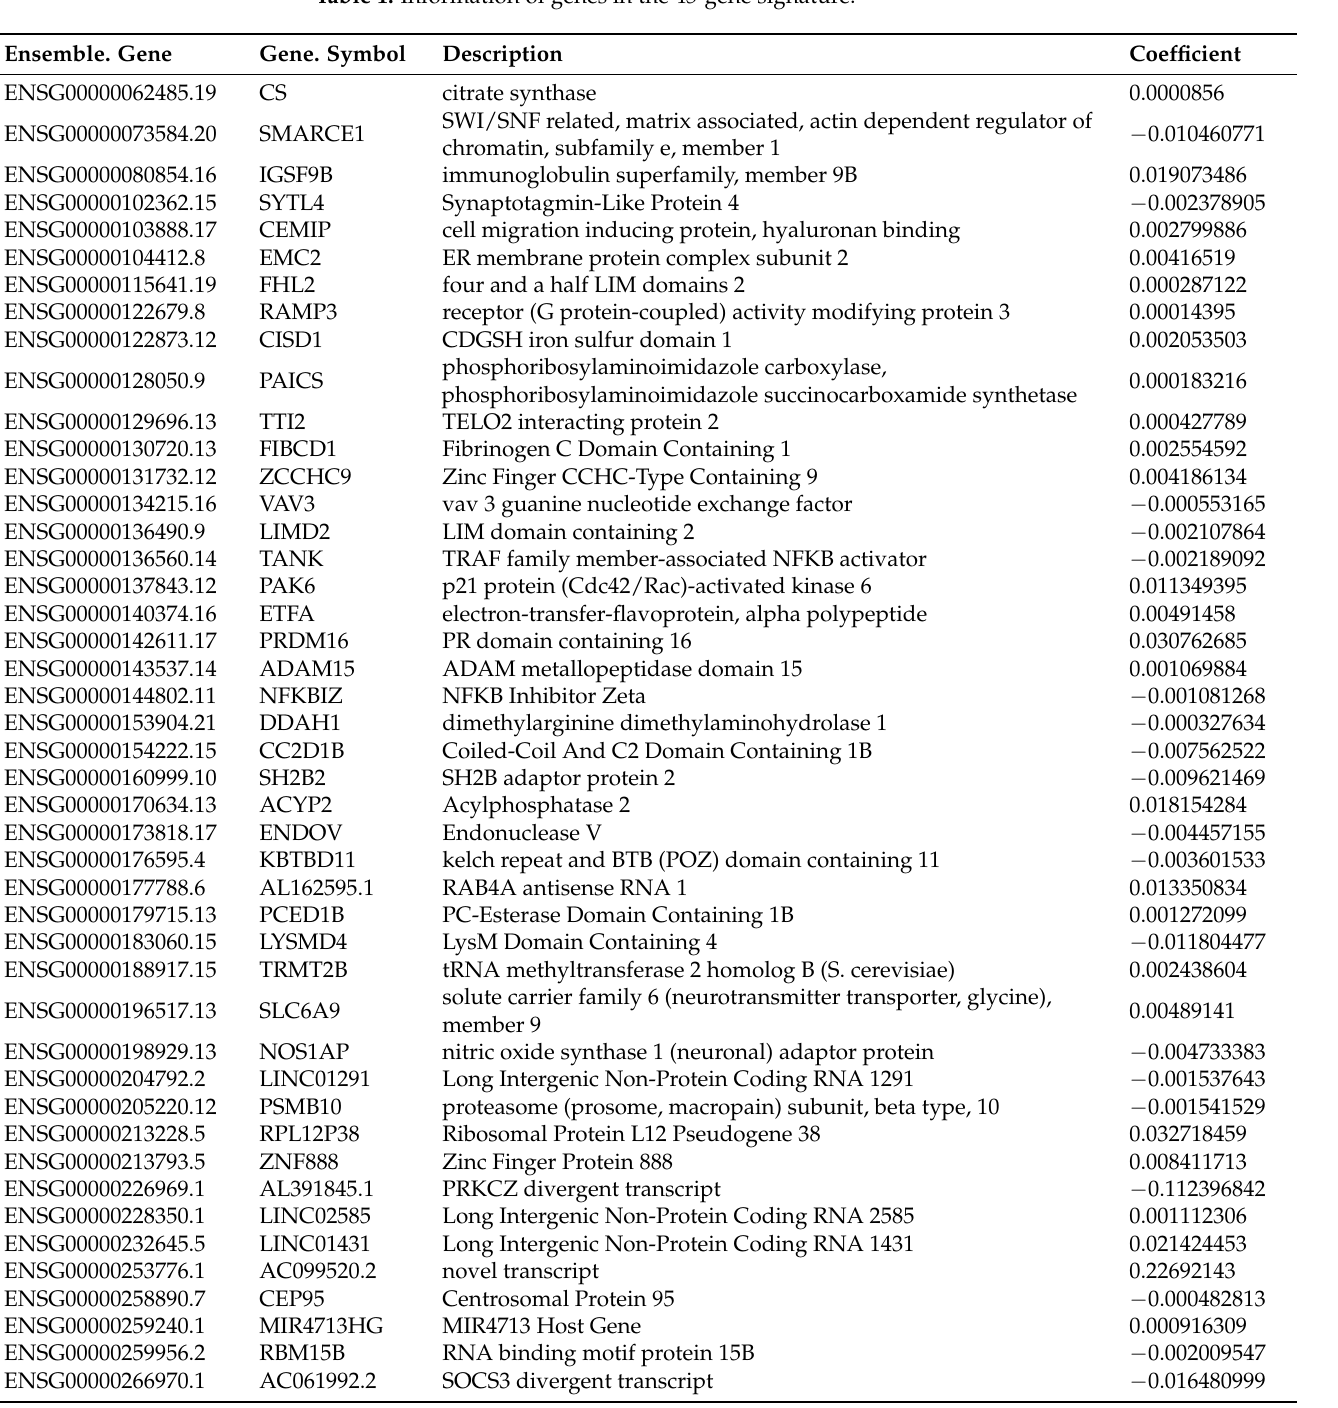
Table 1. Information of genes in the 45-gene